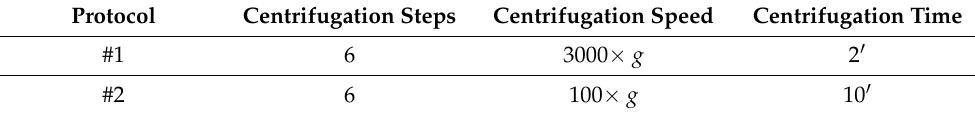
Table 1. Protocol description for column mode purification with Endotrap HD 1 mL